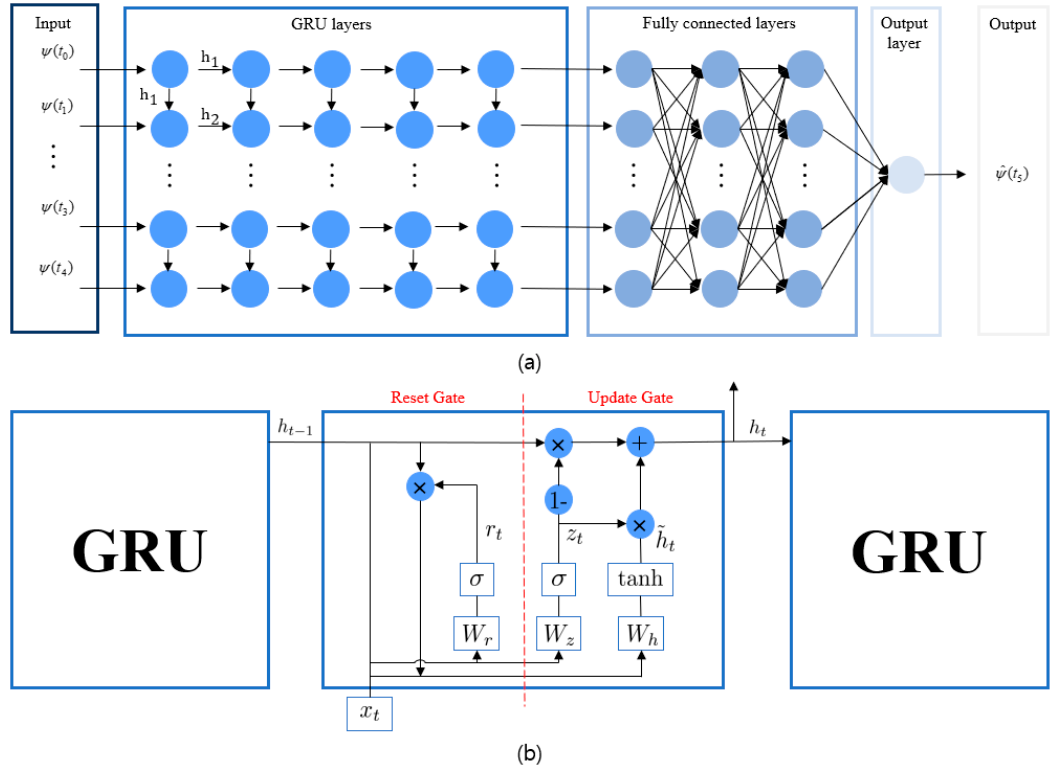
Figure 6. Architecture of Gated Recurrent Unit (GRU) network for predicting yaw angle and GRU cell. ( a ) GRU network. ( b ) A GRU cell where × is element-wise multiplication.